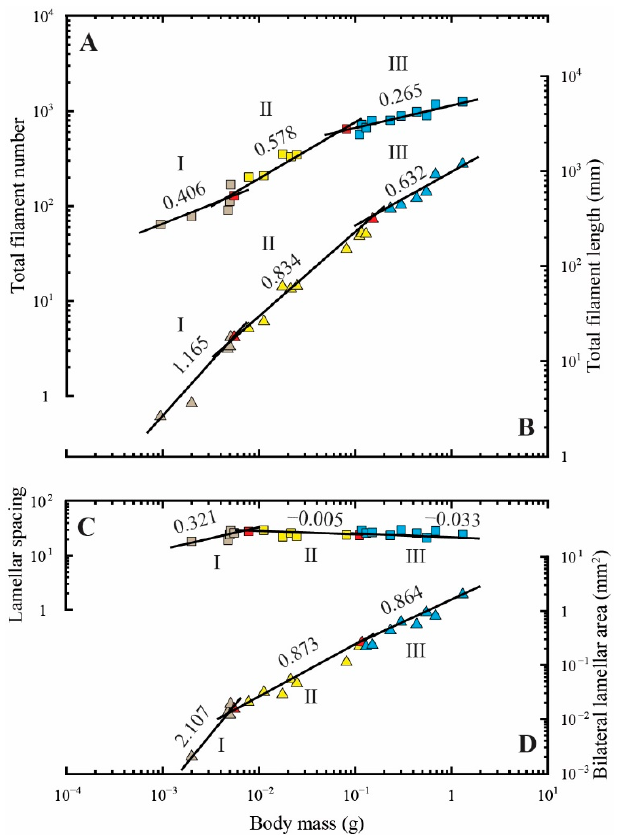
Figure 3. Allometric relationships between body mass and total filament number (colored squares) ( A ); total filament length (colored triangles) ( B ); average spacing of the gill secondary lamellae on one side of the filament (colored squares) ( C ); average bilateral lamellar area (colored triangles) ( D ). The values above the regression lines indicate their slopes. The ontogenetic phase shifts are presented in three colors (gray, phase I; yellow, phase II; blue, phase III). The red-colored spots indicate the measurements that overlap between phases I and II and between phases II and III.